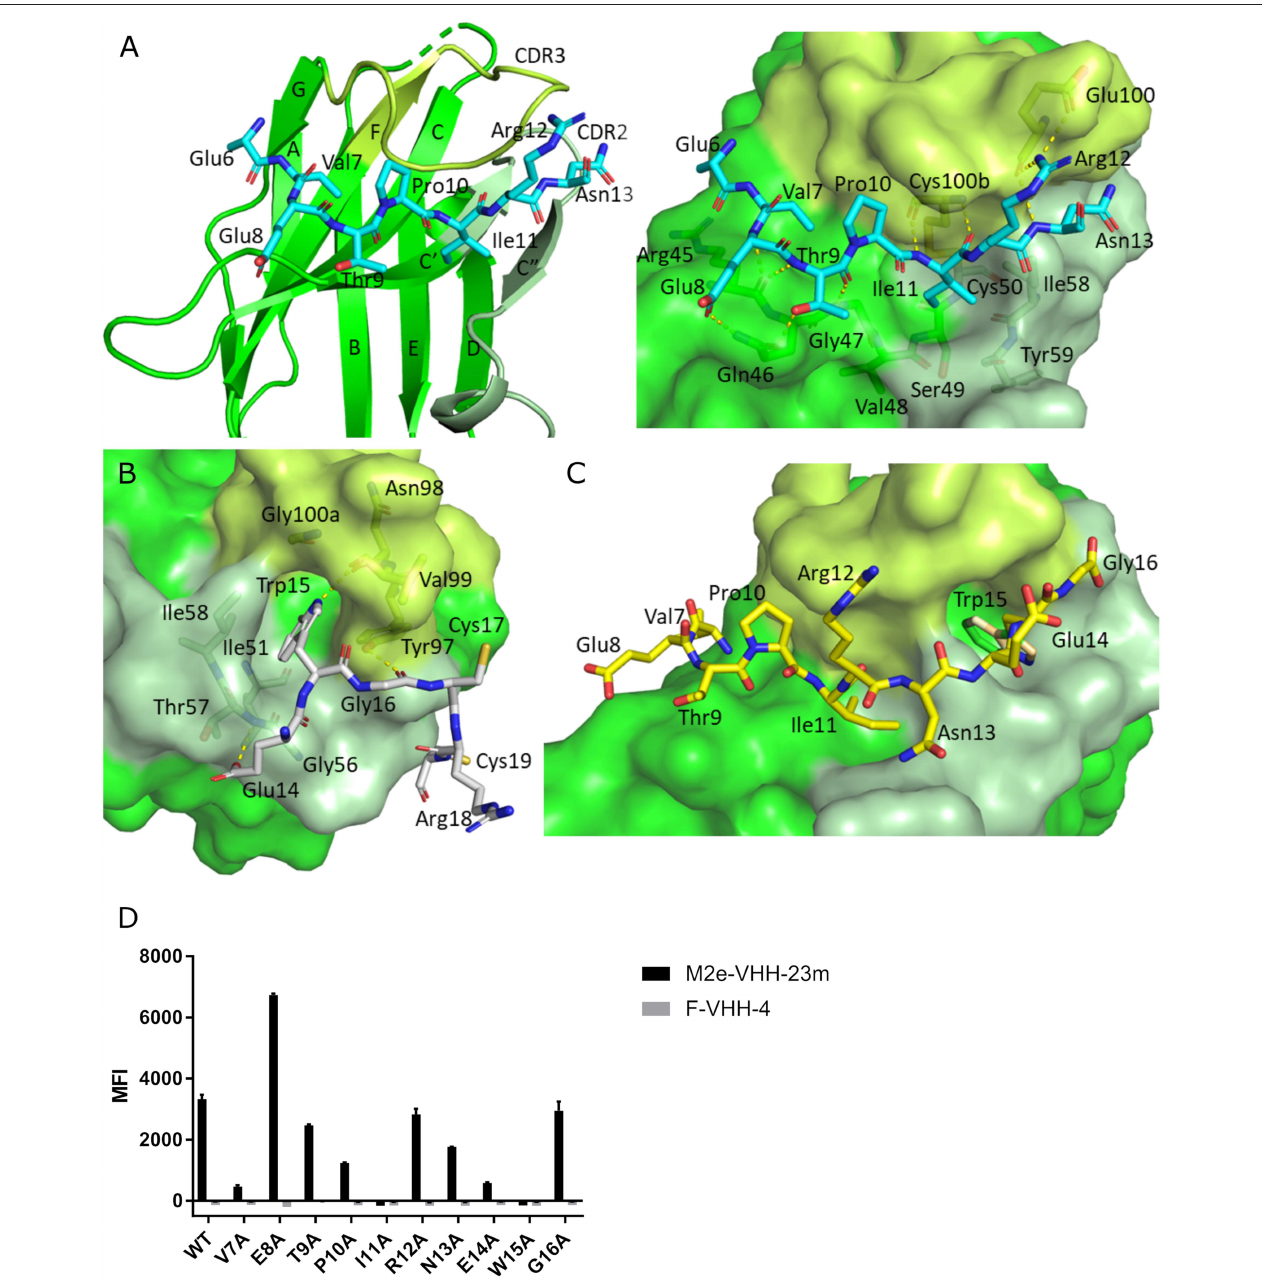
FIGURE 3 | Molecular details of the M2e-VHH-23m: M2e interaction . (A) Crystal structure of M2e-VHH-23m in complex with the M2e peptide, showing the linear binding epitope of M2e residues 6–13 binding to a shallow groove on the surface of M2e-VHH-23m (Interface 1). Left: The M2e peptide is shown in cyan stick representation, the M2e-VHH-23m in green cartoon representation. CDR2 and CDR3 are colored pale and lime green, respectively. Right: Details of the interactions between M2e residues 6–13 and the residues making up interface 1 on M2e-VHH-23m. (B) Details of the interactions between M2e residues 14–19 and the residues making up interface 2 on M2e-VHH-23m. Coloring of M2e-VHH-23m as in A, M2e shown in gray stick representation. (C) Docking of the M2e peptide on the crystal structure of M2e-VHH-23m confirms the ligand swapping hypothesis, showing that M2e binds an extended grove on M2e-VHH-23m comprising both Interface 1 and Interface 2. Coloring of M2e-VHH-23m as in A, M2e shown in yellow stick representation. (D) Binding of M2e-VHH-23m to M2e Ala scan mutants. HEK293T cells were transfected with Flag-tagged M2 wild type (WT) and M2e Ala scan mutant expression constructs and subsequently incubated with 20 µ g/ml of M2e-VHH-23m or F-VHH-4. After fixation with 2% paraformaldehyde and permeabilization, binding was detected with a mouse anti-Histidine tag antibody and rabbit anti-Fag tag antibody followed by an anti-mouse IgG Alexa 647 and anti-rabbit IgG Alexa 488, respectively. The median fluorescence intensity (MFI) was calculated by subtracting the median fluorescence of binding of M2e-VHH-23m or F-VHH-4 to transfected cells from the median fluorescence of non-transfected cells bound by M2e-VHH-23m or F-VHH-4.